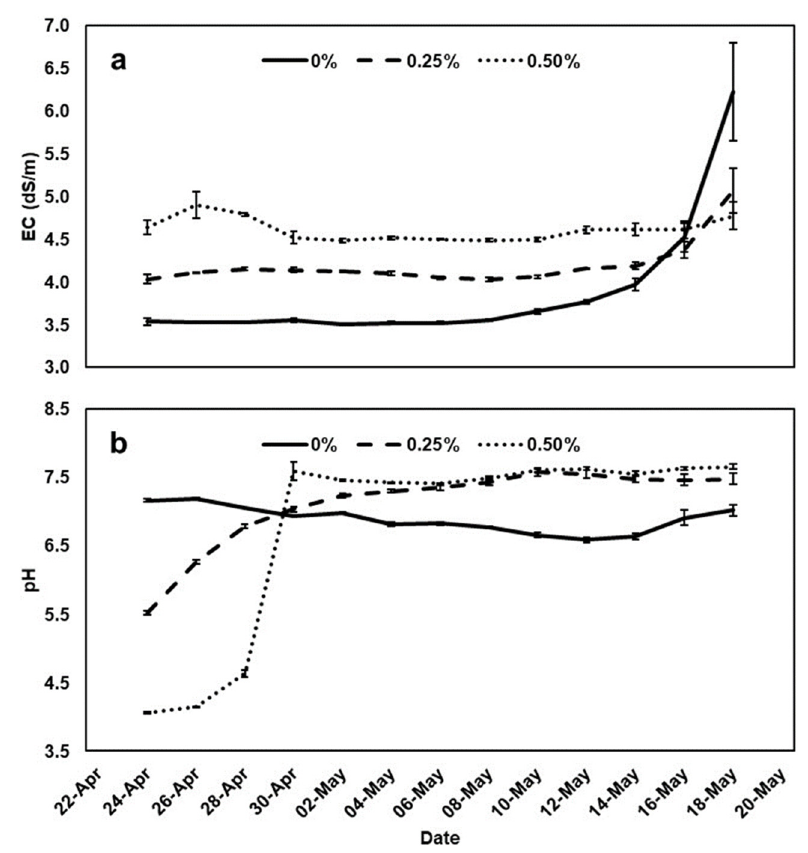
Figure 1. Electrical conductivity (EC) ( a ) and pH ( b ) of the nutrient solutions (NSs), in which 0, 0.25 or 0.50% of a commercial protein hydrolysate (PH) solution (Amino16 ® ) was added during peppermint and spearmint cultivation in a floating system. Each value is a mean of three repli- cates.